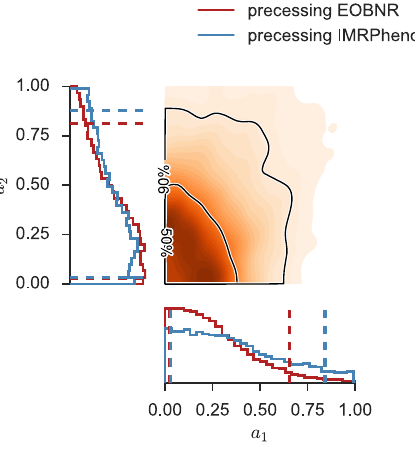
FIG. 3. Posterior probability densities for the dimensionless spin magnitudes. (See Fig. 2 for